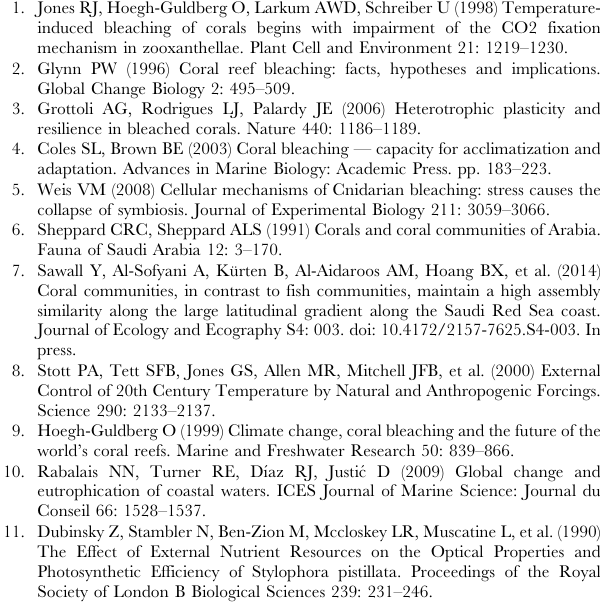
Table S4 Results of correlation and regression analy- ses. Dependent variables are the zooxanthellae characteristics density, photo-collecting pigments, and protein cell 2 1 and the ratio xanthophyll/chl a . The predictor variables (pred. var.) include the environmental parameters temperature ( T ), nutrients ( N [flow*chl a ]) and light ( L [PAR]). Significant results are in bold (p . 0.05). Analyses were conducted with complete data sets (season: all, site: all) and seasonal sub-sets (season: Sep or Mar, site: all) to differentiate between overall patterns across sites and seasons and pure geographic patterns (N-S), respectively. Further- more, comparison of results between complete data sets and seasonal sub-sets allowed discriminating between seasonal and geographic responses to environmental variability. Since the correlation between temperature and nutrients or light was always significant within the seasonal sub-sets, no stepwise forward regression analyses were performed with these data sets, but partial correlation